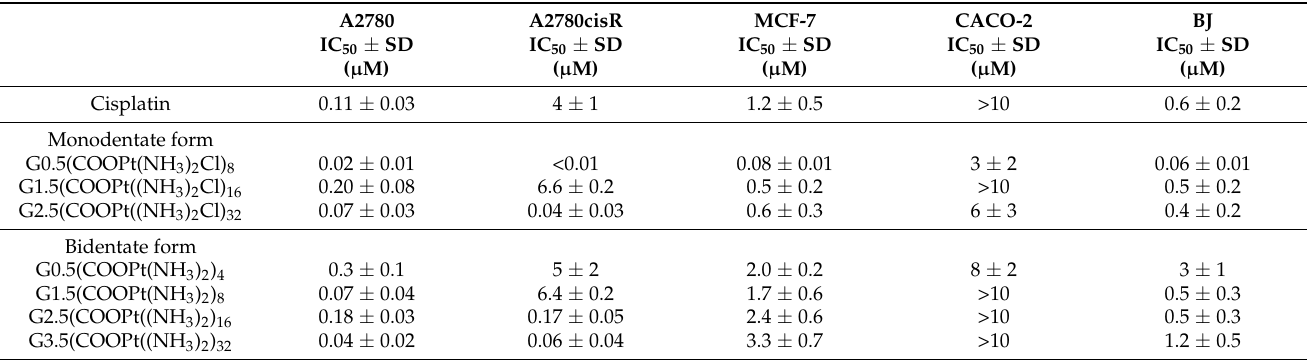
Table 3. IC 50 values of the prepared metallodendrimers towards various cancer and non-cancer cell lines. Results are expressed as mean ± SD of three independent experiments performed in triplicate.